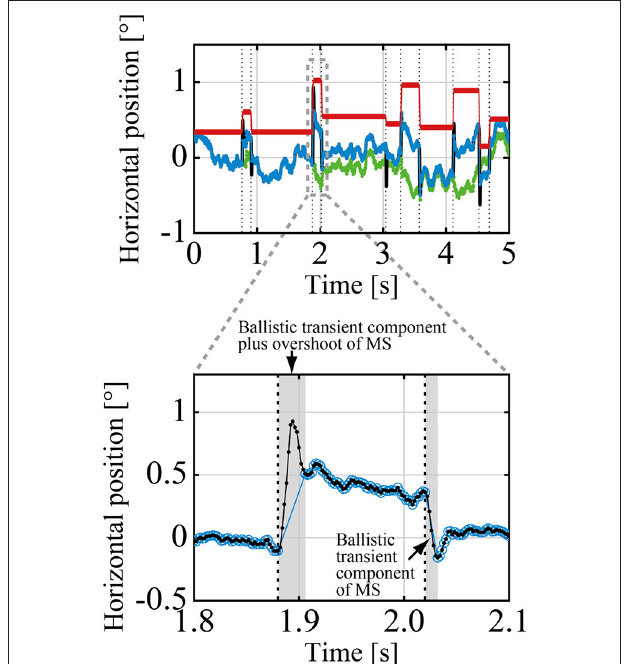
FIGURE 2 | A representative example of the raw-GZ time series X rGZ ( t ) (black curve, mostly behind the blue curve), the GZ time series X GZ ( t ) (blue curve), which was decomposed into the drifts-tremor (DRT) time series X DRT ( t ) (green curve), and the microsaccade (MS) time series X MS ( t ) (red line). The vertical dotted lines indicate the time instances when MS events (MS onset and offset) occurred. The enlarged view compares the details of the raw-GZ time series X rGZ ( t ) (small black filled circles) with the transient and overshoot ballistic components of two MS events and the GZ time series X GZ ( t ) (blue open circles). The transient and overshoot ballistic components were eliminated from the raw GZ to obtain the GZ time